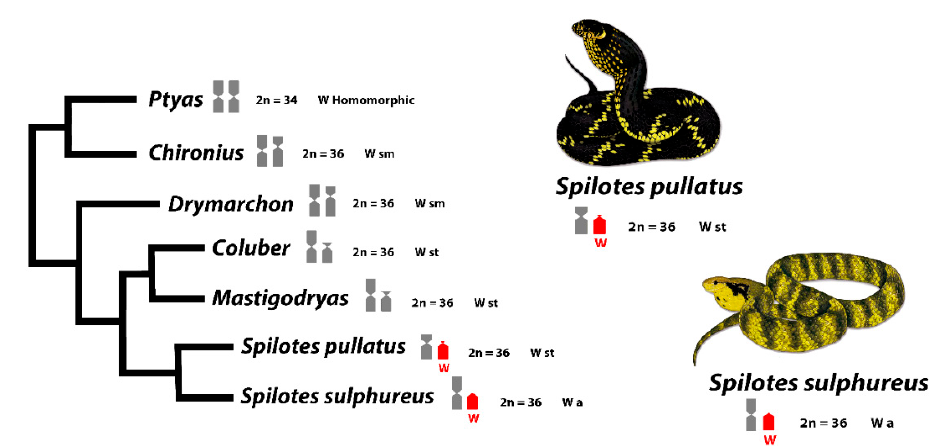
Figure 4. Truncated phylogeny of Caenophidian snakes including Spilotes and closely related species showing patterns of sex chromosomes di ff erentiation. The red color highlights the shared W chromosome sequences between species revealed by CGH. Tree topology is adapted from [55]. The sm (submetacentric), st (subtelocentric), and a (acrocentric) corresponds to the W’s morphologies. Illustrations by Bruna Borges.